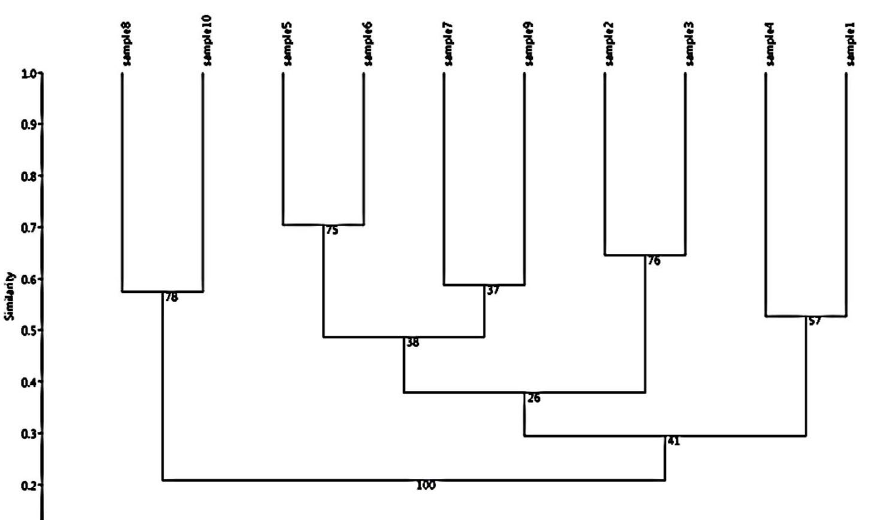
Fig. 7. Dendrogram analysis showing the phylogenetic diversity of fenugreek ( Trigonella foenum-graecum ) leaf samples: 1, control; 2, Th-1; 3, Th-2; 4, AVG; 5, MeJA; 6, Th-1 + AVG; 7 Th-1 + MeJA; 8, Th-2 + AVG; 9, Th-2 + MeJA; 10, MeJA + AVG; characterized by random amplified polymorphic DNA (RAPD) markers (OPX-8, OPA-18, OPA-5, OPW-2,